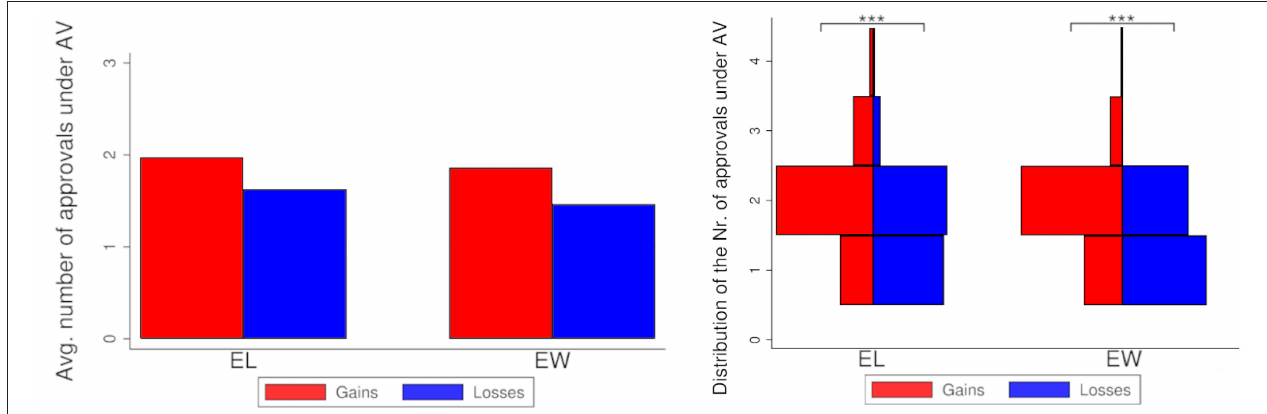
FIGURE 5 | Society 2. Left : Number of approvals by treatment and group of voters. Right : Distribution of the number of approvals by treatment and group of voters. Stars refer to the significance of non-parametric tests ( ∗∗ p < 0.01 ∗∗∗ p < 0.001).